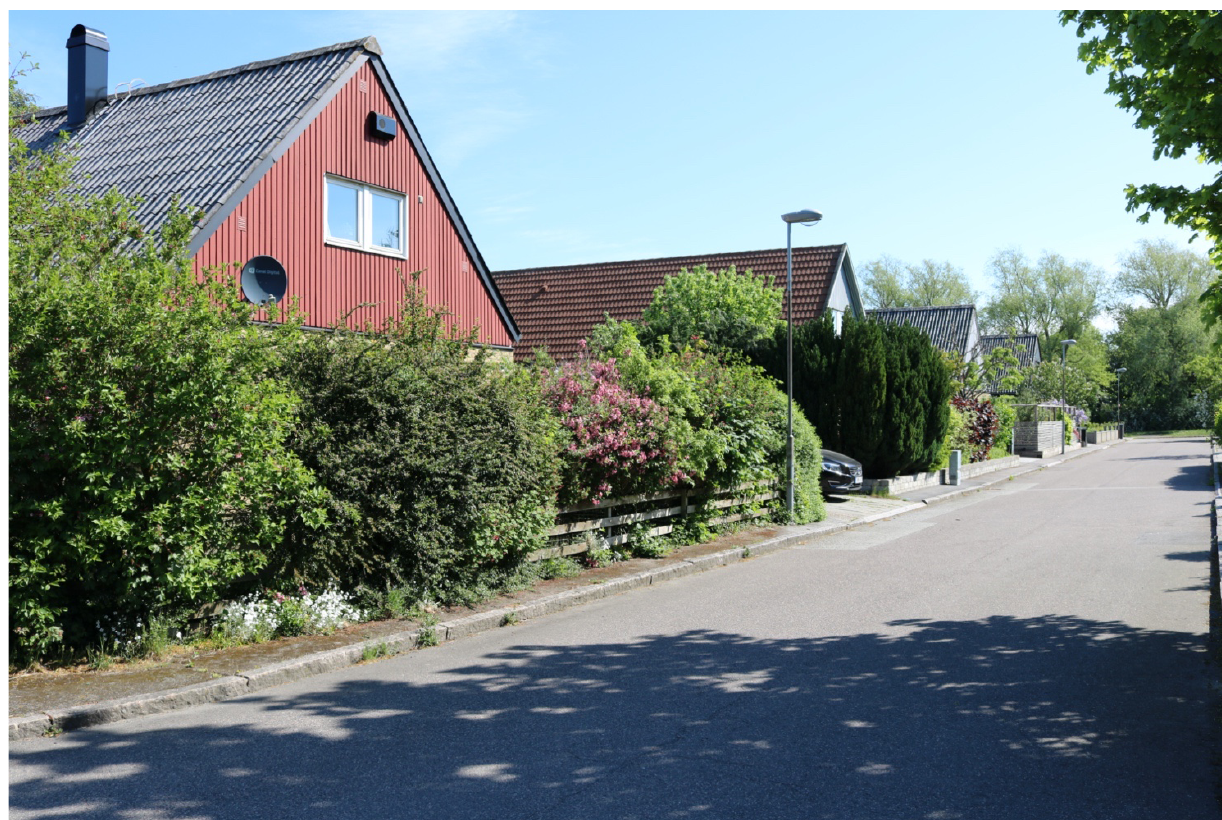
Figure 5. Single-family housing in the part of Stångby built in the 1960s, where every single unit has a driveway to park the car. Source: